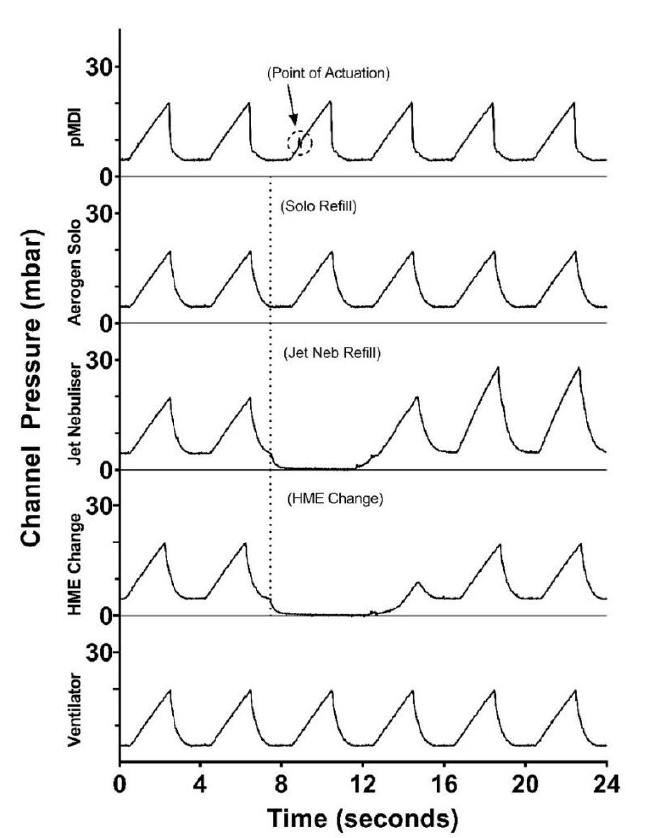
Figure 7. Ventilator circuit pressure change during nebuliser drug refill, pMDI actuation and HME change. Testing was completed using a pressure sensor. Results are presented as circuit pressure in mbar over time in seconds.